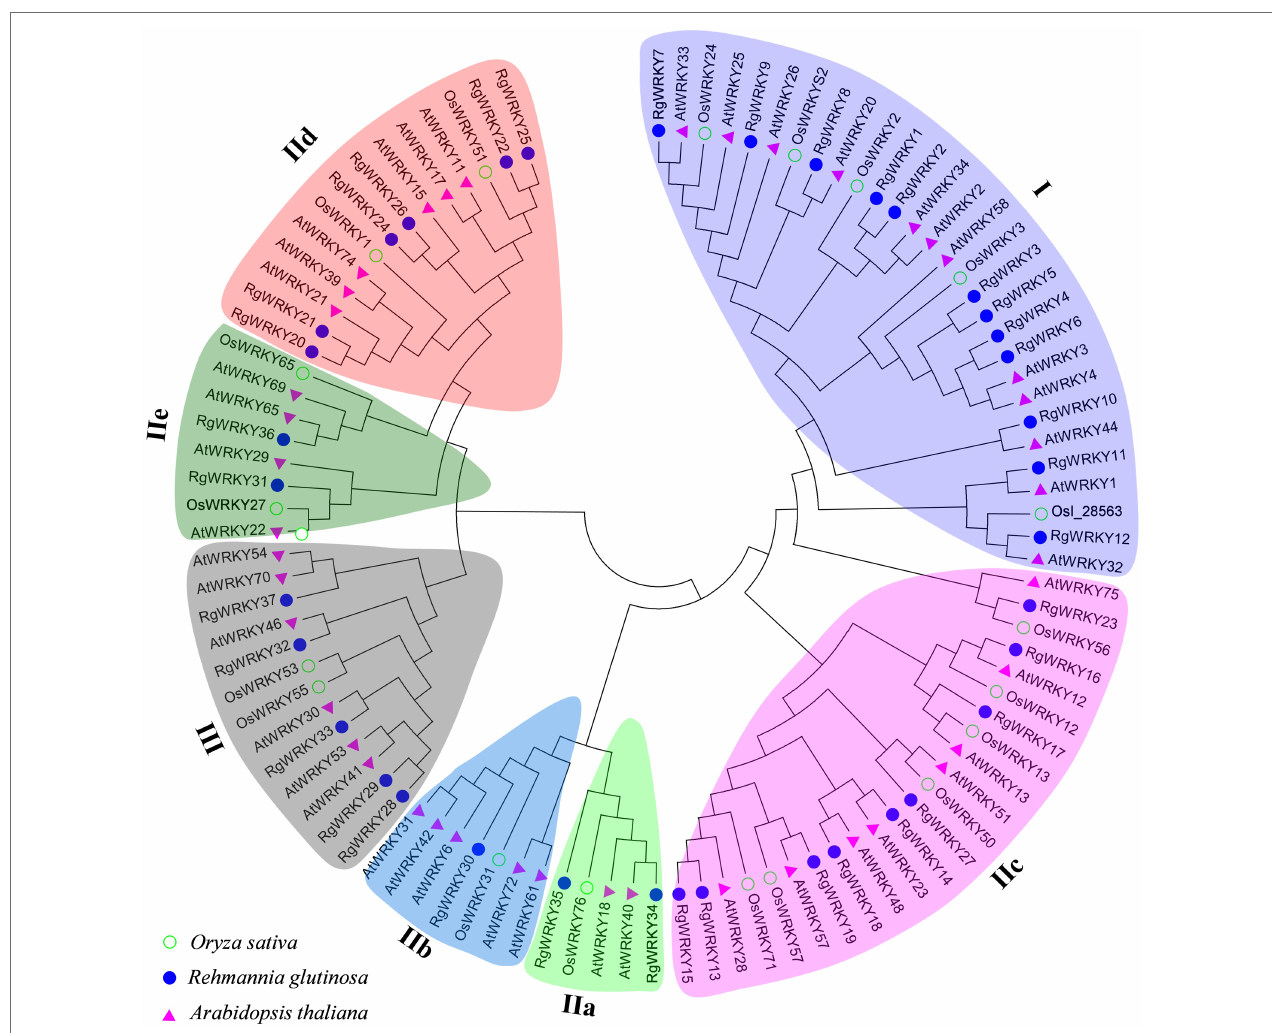
FIGURE 1 | Phylogenetic tree of the WRKY transcription factors from Rehmannia glutinosa , Arabidopsis and rice. The full-length sequences of the WRKY proteins were aligned using MAFFT, and the phylogenetic tree was constructed using the neighbor-joining method in the MEGA6 software (Tamura et al., 2013). Bootstrap values (shown at the corresponding nodes) were obtained from 1,000 replicates and are reported as percentages. The black arcs indicate different groups (or subgroups) of WRKY